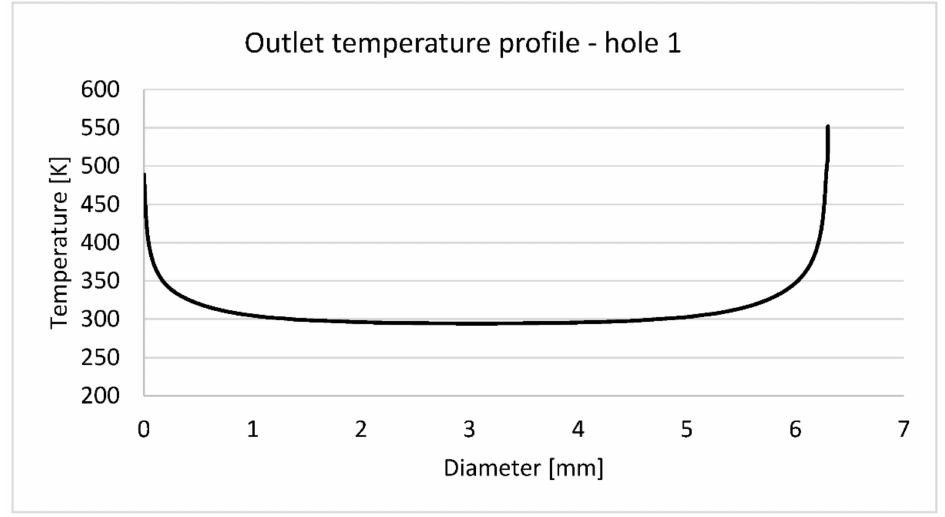
Figure 12. Outlet temperature distribution along the diameter highlighted on Figure